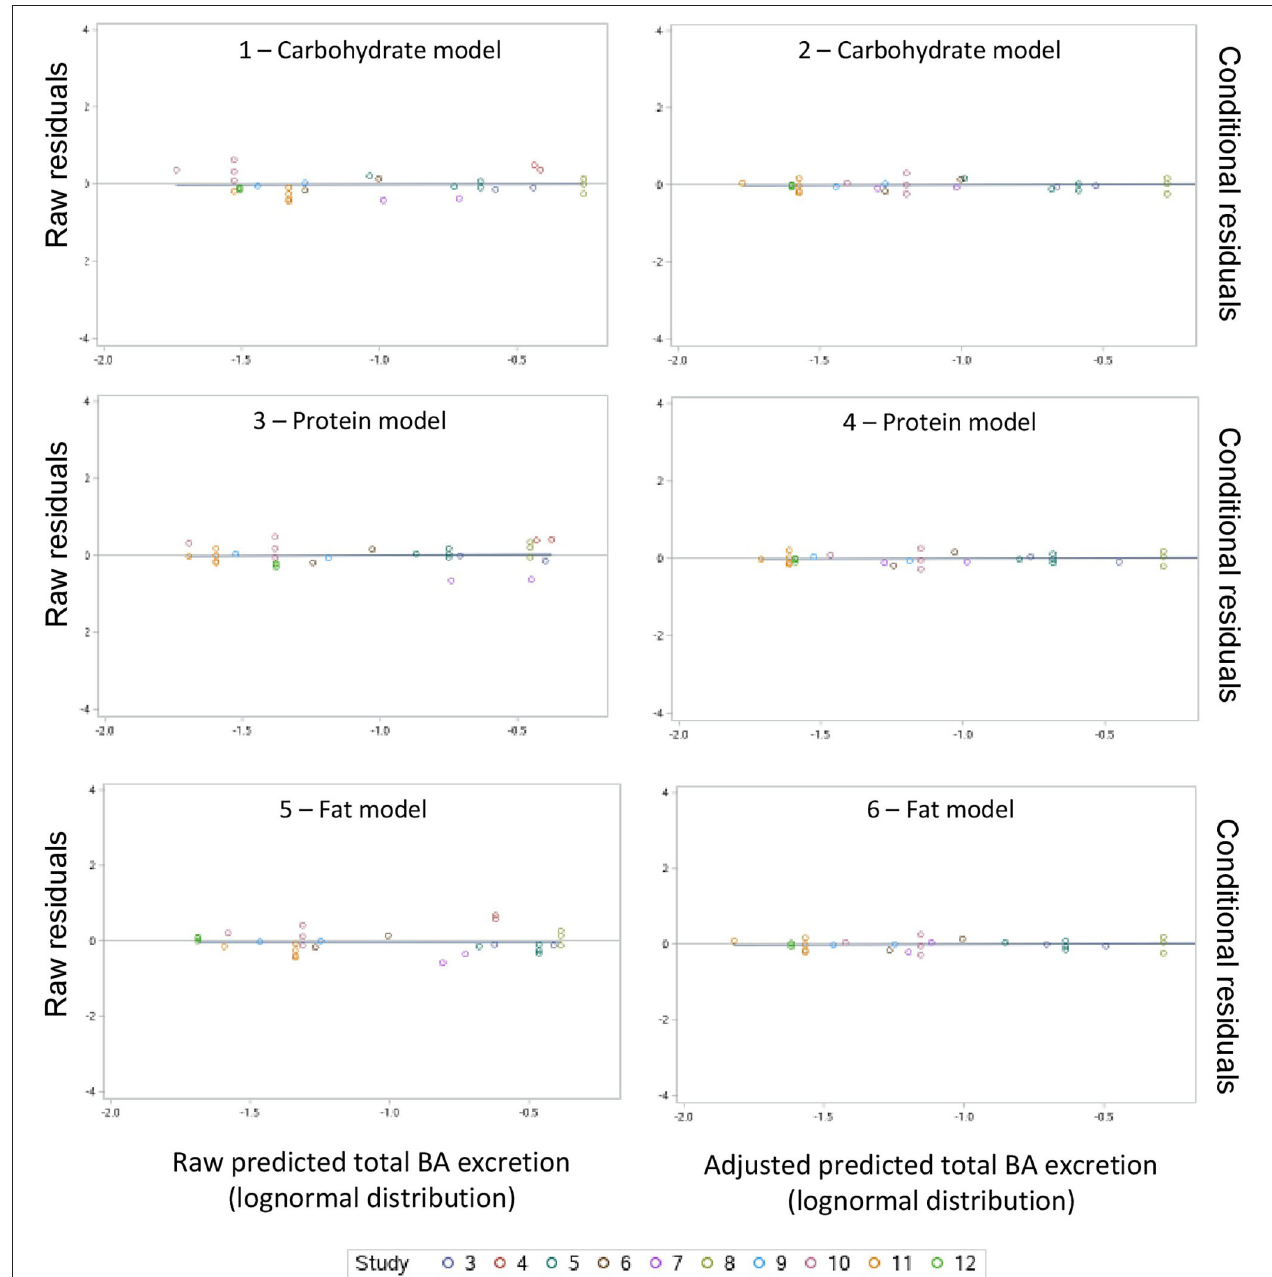
FIGURE 4 | Raw residuals (predicted – observed) vs. raw predicted and conditional residuals vs. adjusted predicted plots for the carbohydrate, protein and fat models.